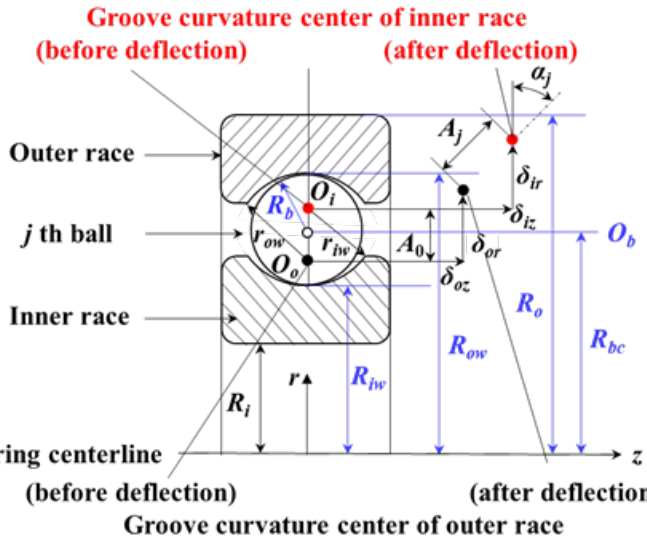
Figure 6. The geometrics of ball bearings including groove curvature centers of raceways before and after deflection.